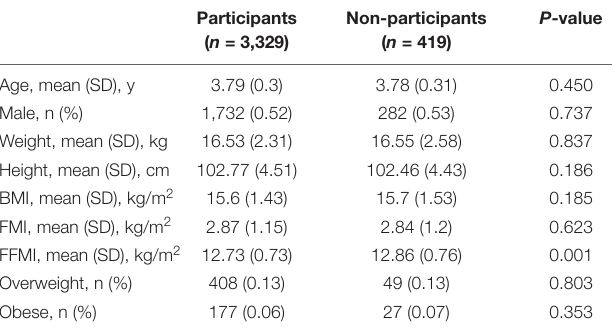
TABLE 1 | Characteristics of children at junior class with and without GWG data that as participants and non-participants in the follow-up study. Participants ( n =